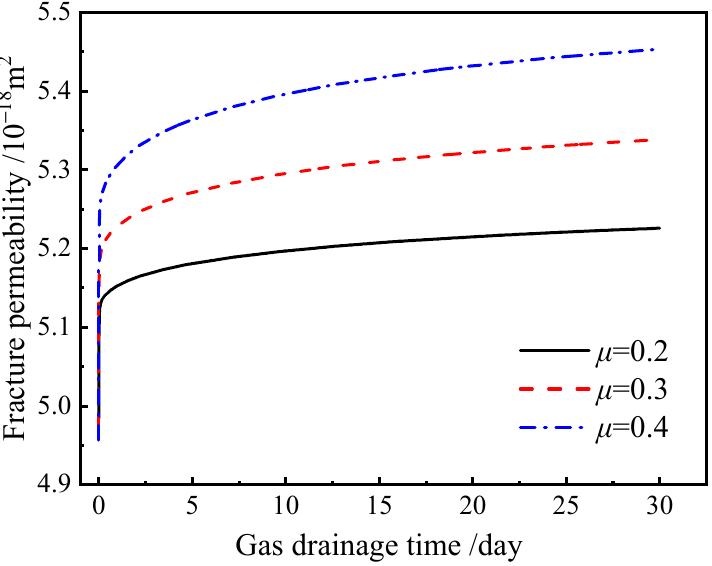
Figure 8. The effect of non-uniform coefficient on fracture permeability evolution.